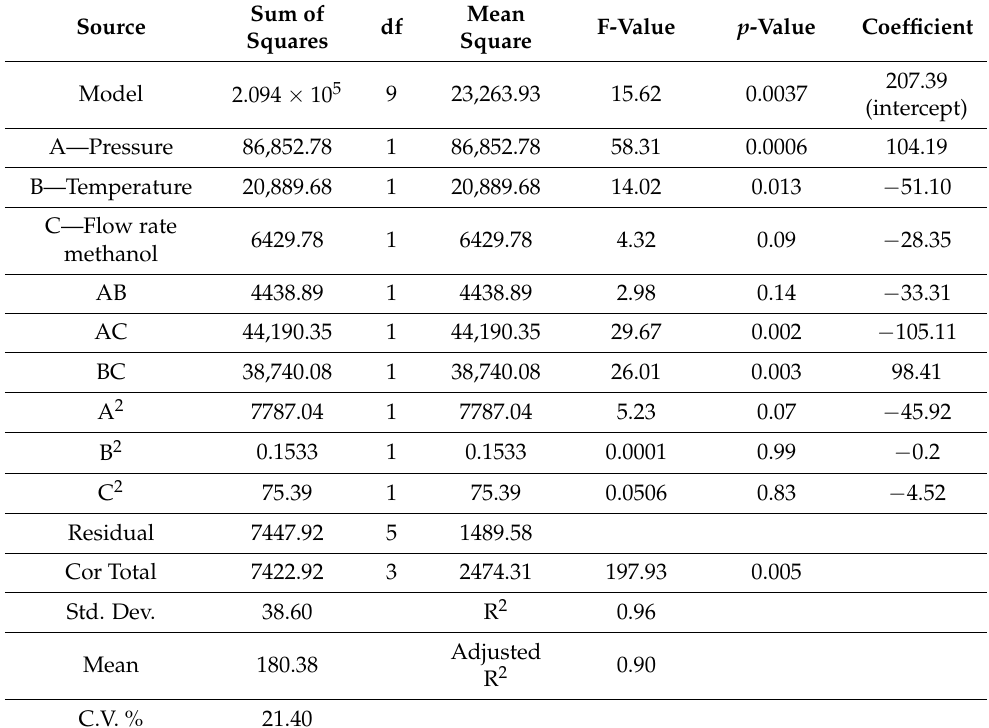
Table 3. ANOVA table of epicatechin recovery by SME.